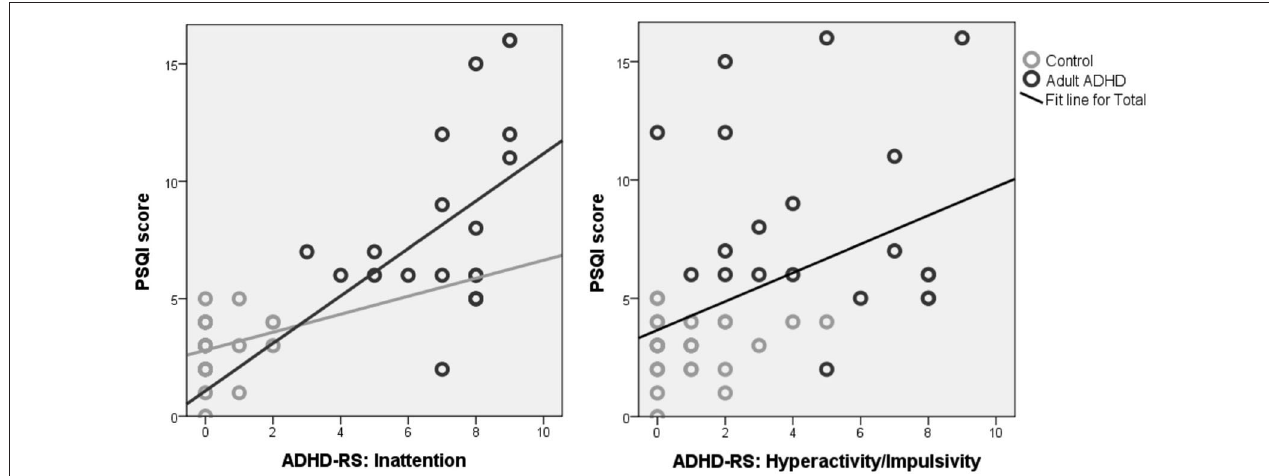
controls (gray) to adults with ADHD (black), and for the whole group this association explained 59% of the variance for inattention. For Hyperactivity/Impulsivity the correlation was only significant for the whole group and not for the subgroups, suggesting this is only driven by group differences.